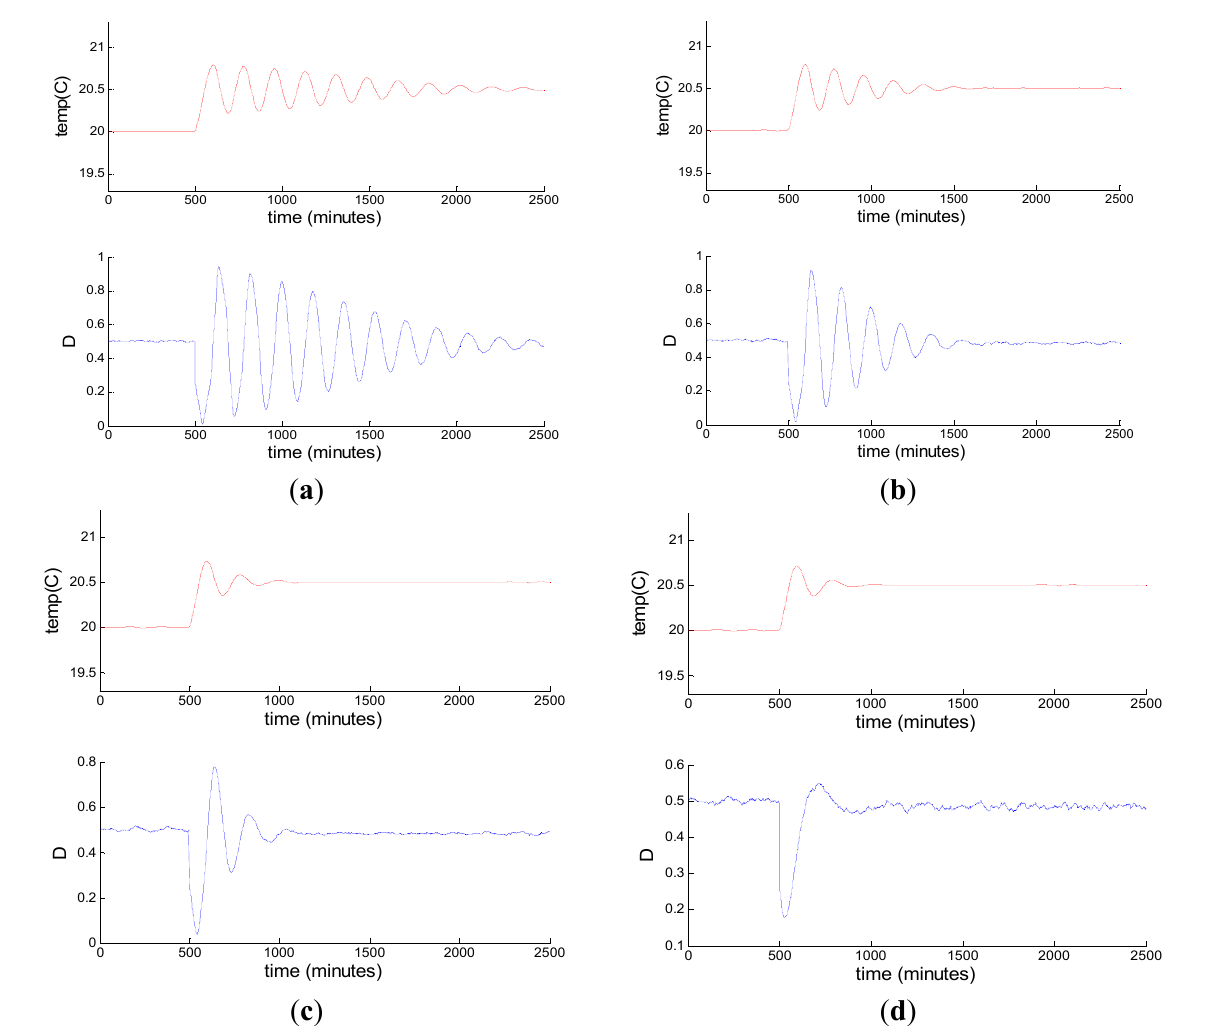
Figure 4. The average temperature and power for the population composed of 10,000 ACs before and after the step signal of temperature set point, respectively under conditions of  = 0.02, 0.05, 0.2 and 0.5.  is the standard deviation of log-normal distributions as a rel rel fraction of the mean value for R , C and P. ( a )  =0.02; ( b rel